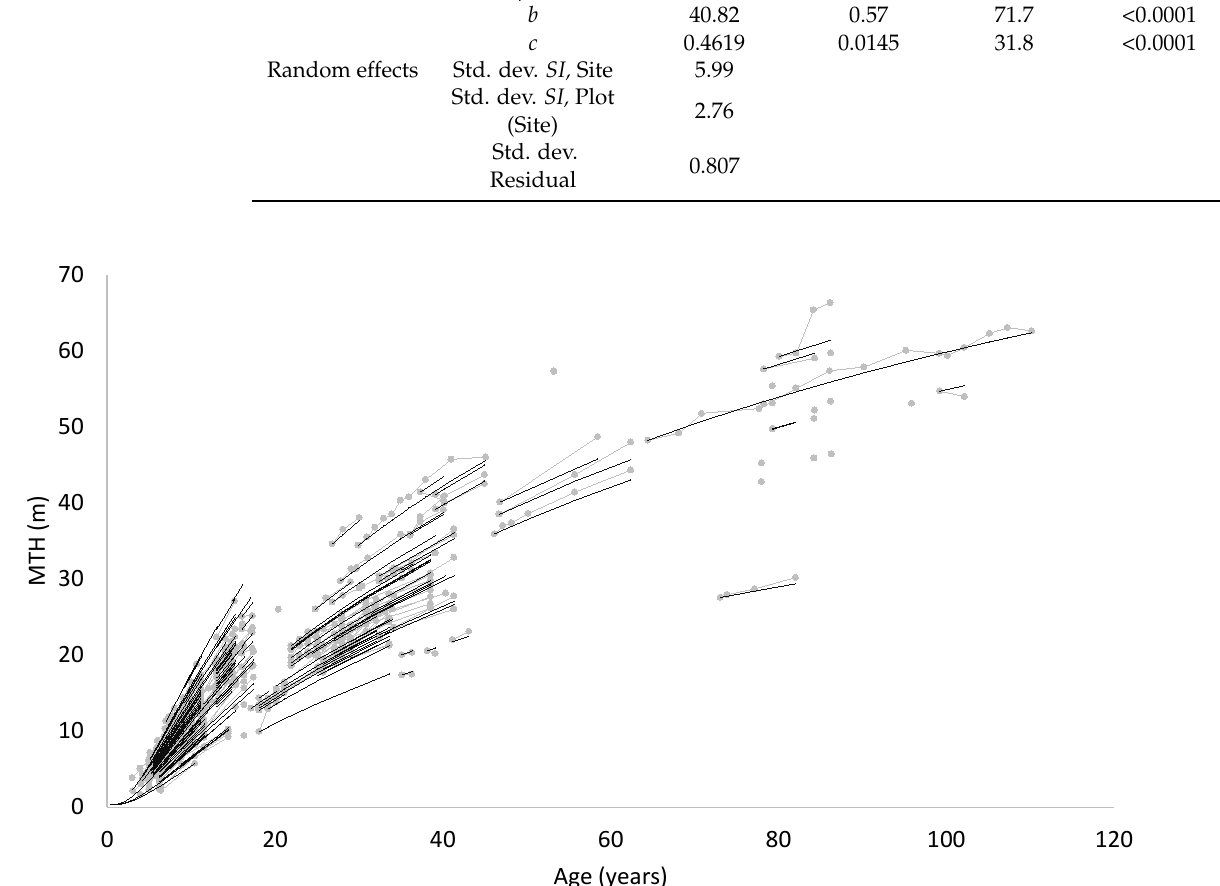
Figure 4. Mean top height vs. age for data from measured stands. Grey dots indicate measurements, with grey solid lines showing plots measured multiple times. Black lines show predictions from Equation (15) based on the initial measurement in each plot.